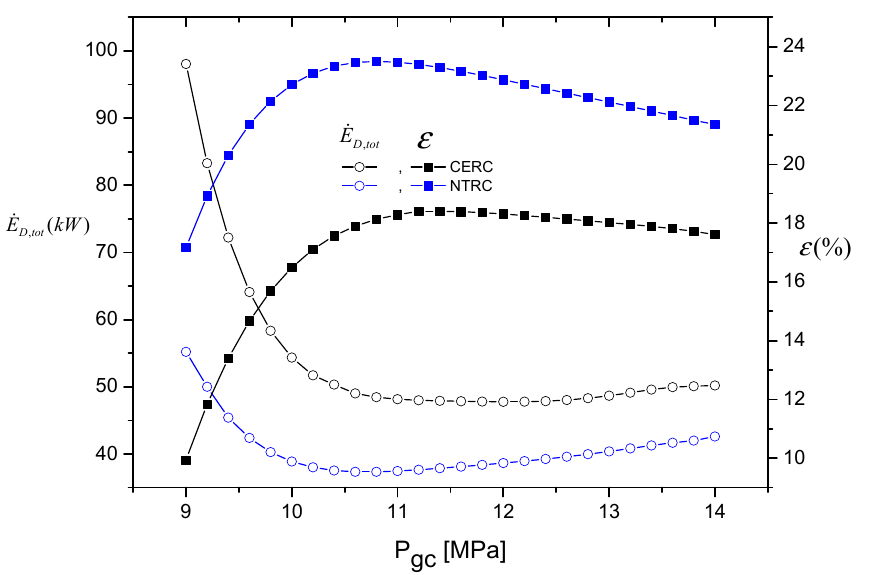
. E D , tot as a function